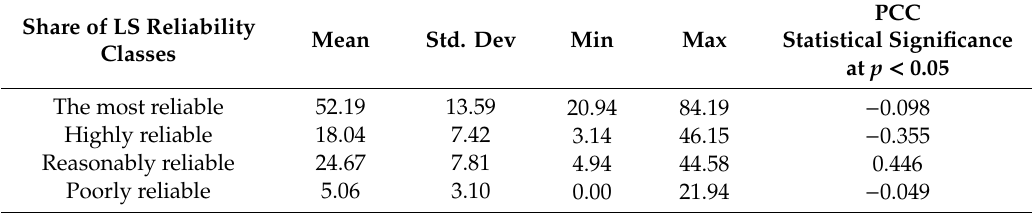
Table 6. Overall global statistics of LS reliability classes shares in districts.